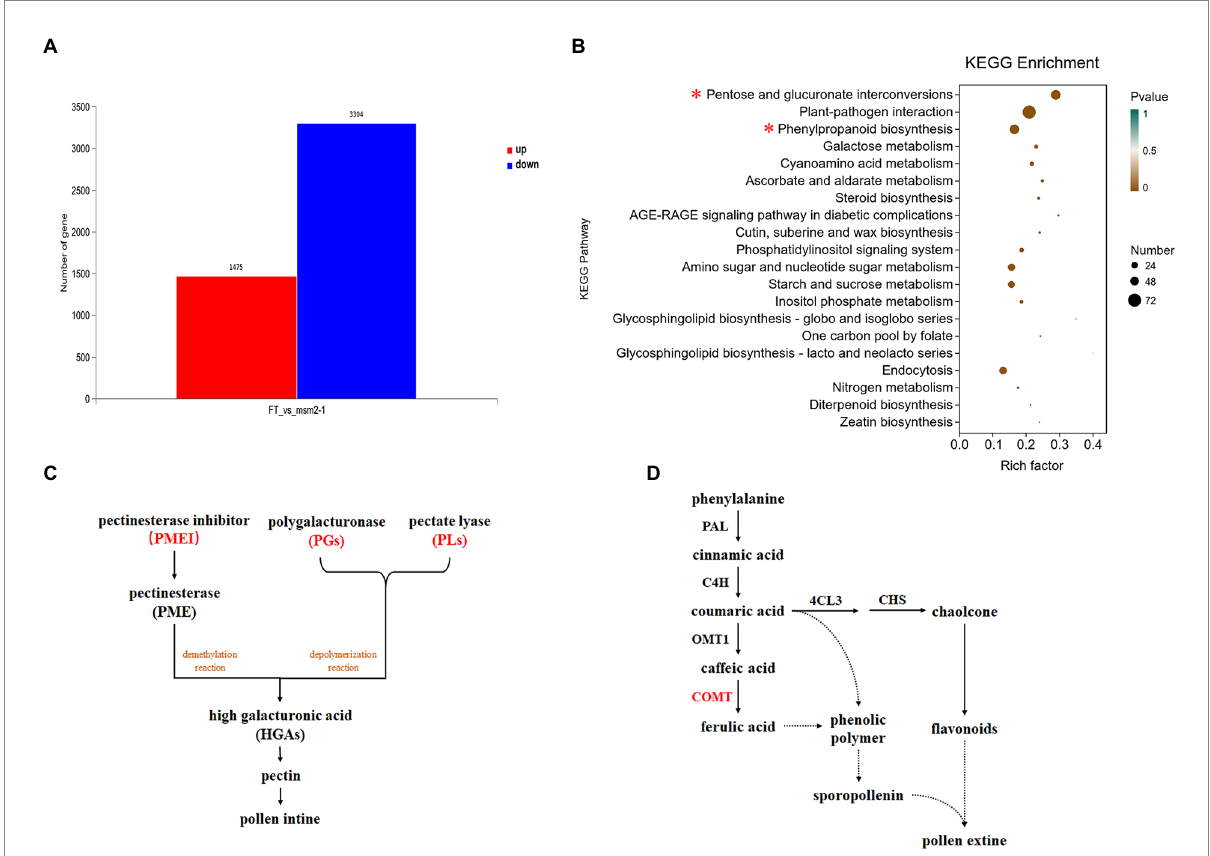
FIGURE 10 RNA-seq analysis between the wild-type “FT” and msm2-1 mutant. (A) The number of different expression genes (DEGs) in the anthers between the wild-type “FT” and msm2-1 mutant. (B) Kyoto Encyclopedia of Genes and Genomes enrichment results of the DEGs. (C) Schematic of pentose and glucuronate interconversions pathway related to pollen development. The red part represents the key enzymes enriched by the differentially expressed genes. (D) Schematic of phenylpropanoid metabolism pathway related to pollen development. The red part represents the key enzymes enriched by the differentially expressed